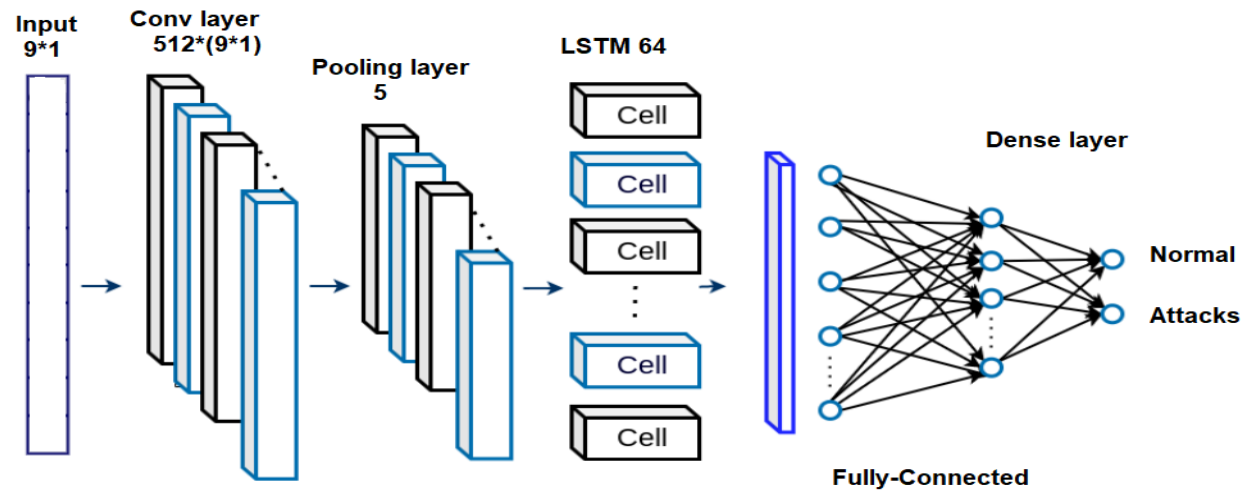
Figure 6. CNN–LSTM model for detecting attacks. Table 3. Using parameters of CNN–LSTM algorithm for detecting attacks.